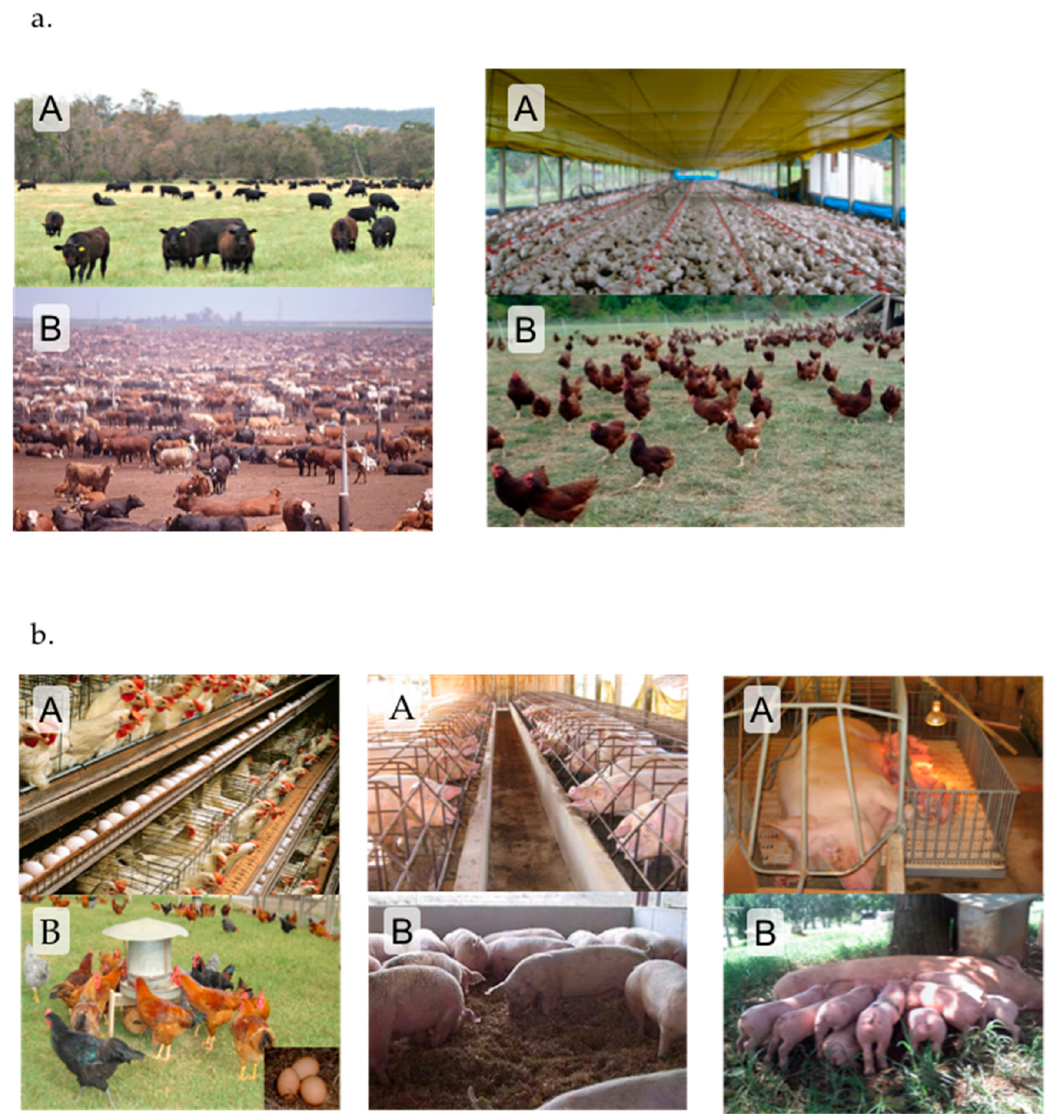
Figure 1. Each respondent were presented with a series of photos ( a ) one example of a non-confined system and a confined cage-free system for the same species (either beef cattle or poultry), and ( b ) one example of a cage-free system and a caged system for a second species (either laying hens, gestating sows, or farrowing sows). The order of the photos was randomized so that each set of paired photos appeared 50% of the time either as the first or second. In each case respondents were asked “which situation (A or B) would you like to be the more common in animal production in Brazil?”